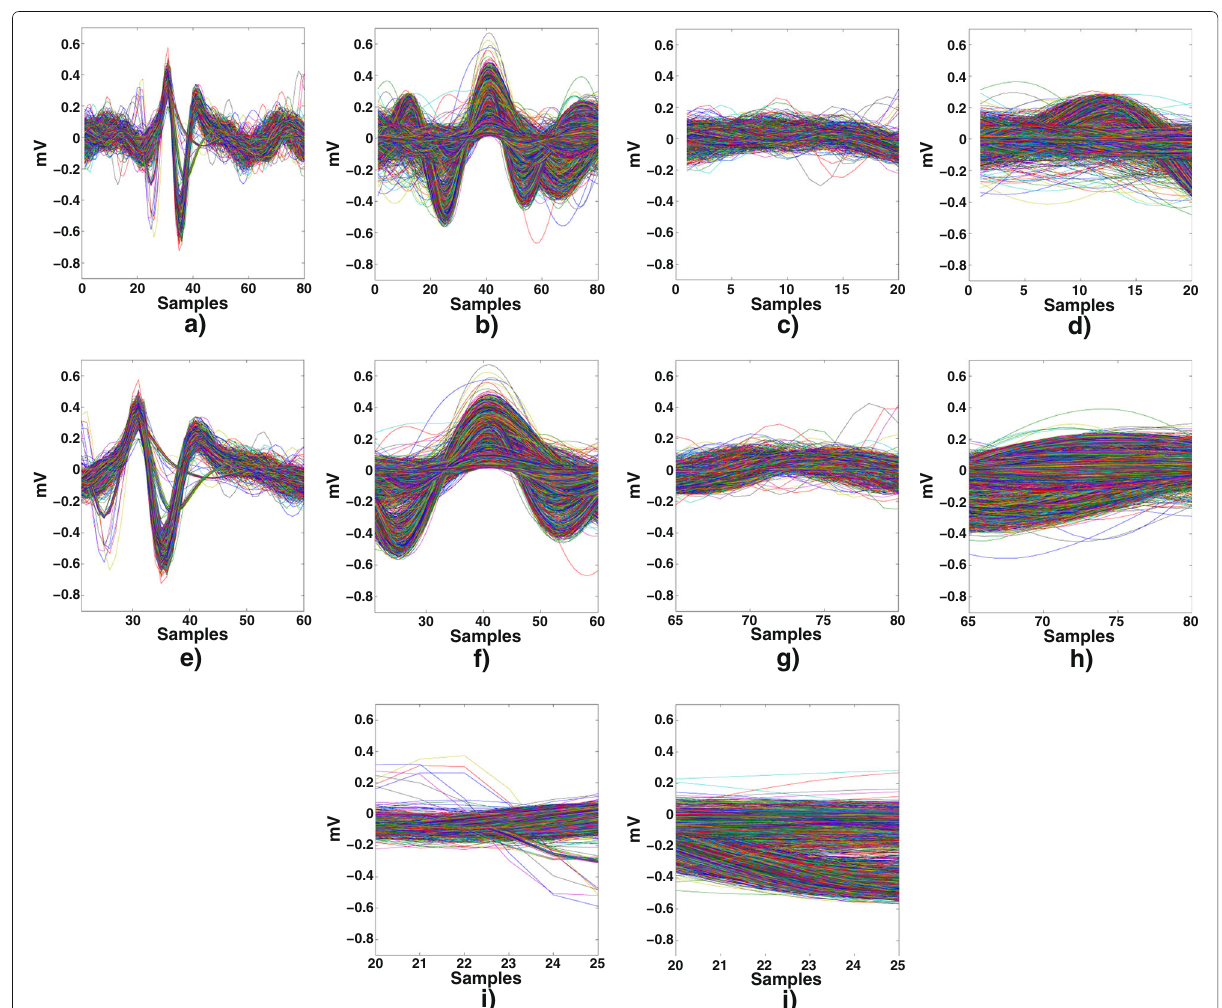
Fig. 2 Proposed method for data extraction of the heartbeats. a Healthy, b arrhythmia, c P wave, d P wave, e QRS complex, f QRS complex, g T wave, h T wave, i P-Q interval, j P-Q interval